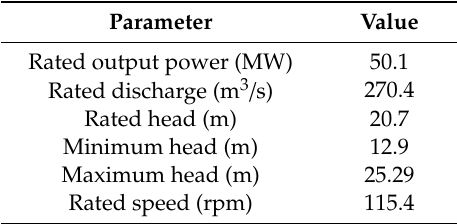
angle ( c ). Table A2. Basic parameters of experimental HHP.